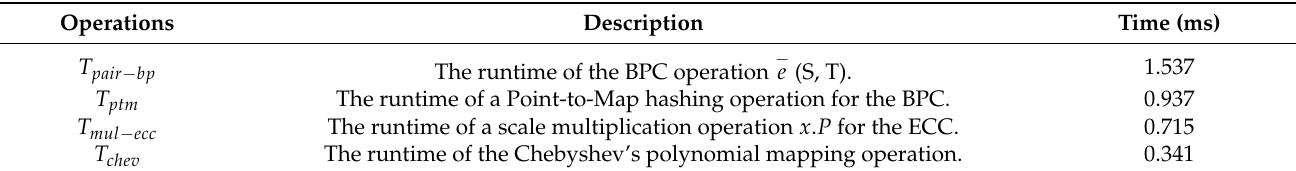
Table 3. Runtime of different cryptographic